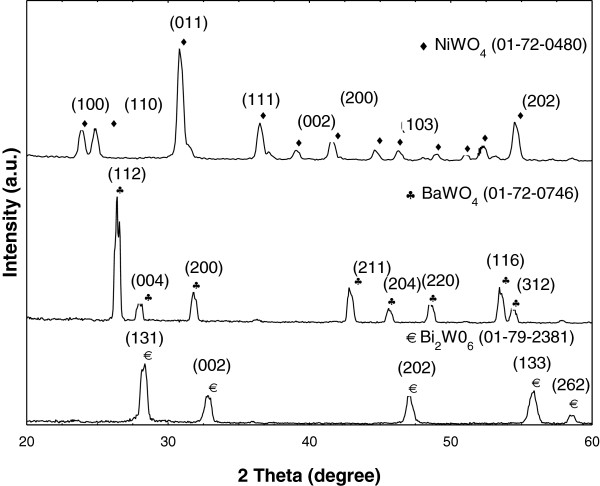
The XRD patterns of NiWO4, BaWO4 and Bi2WO6 samples. All samples were synthesized by sucrose template method.